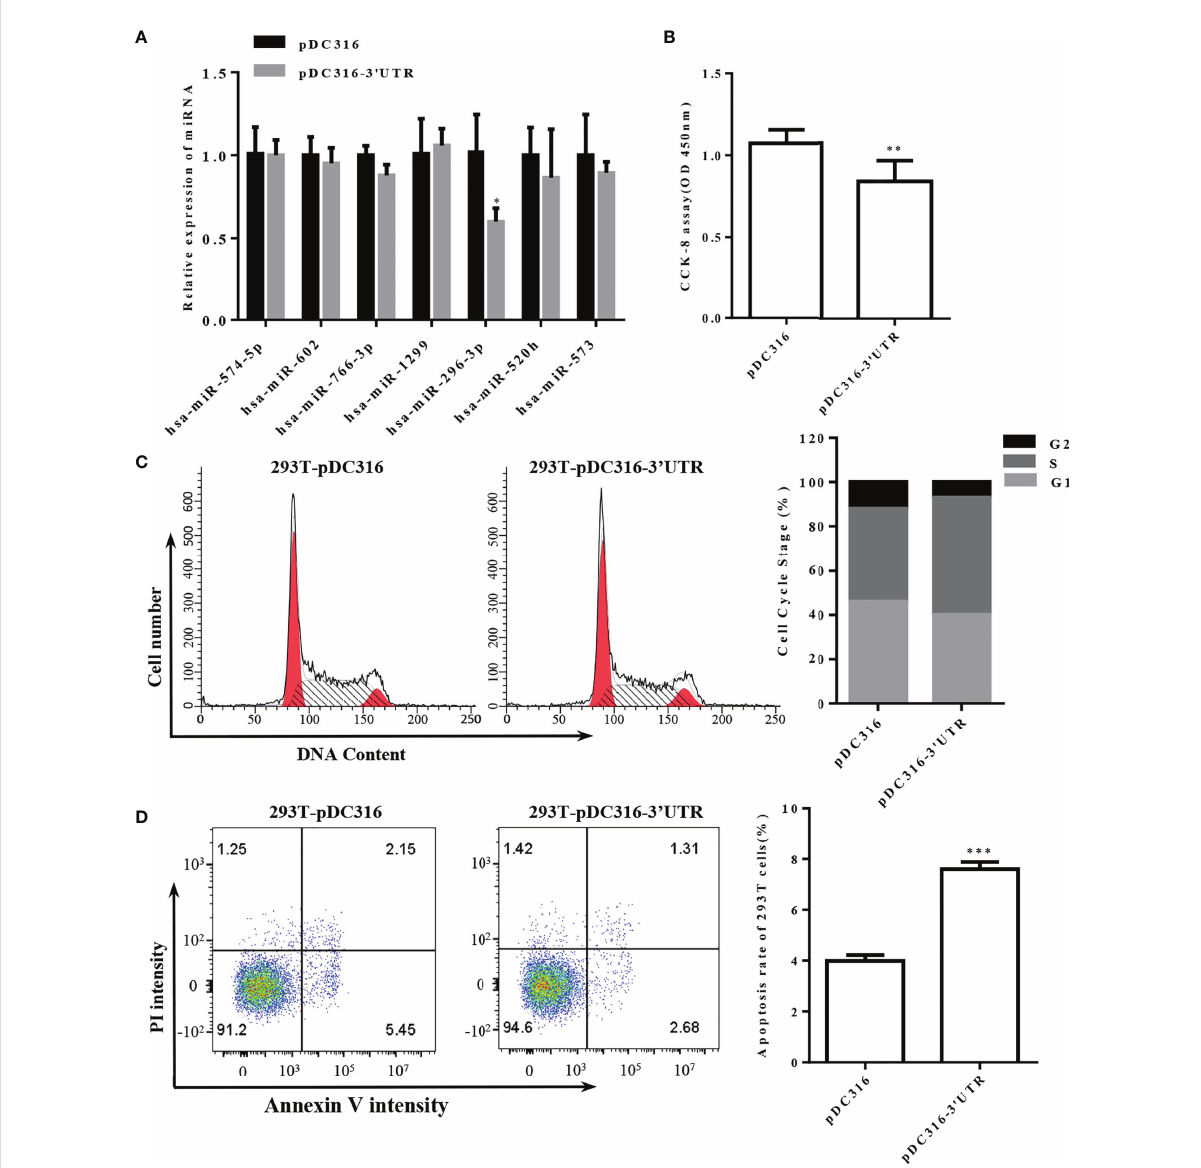
FIGURE 3 Overexpression of S-3 ′ UTR downregulated miR-296 expression and disturbed 293T cell growth. (A) Expression levels of miRNAs following overexpression of S-3 ′ UTR in 293T cells. Note that only expression of miR-296 was reduced. (B) 293T cell proliferation was detected by CCK-8. Note that overexpression of S-3 ′ UTR decreased cell proliferation. (C) Distribution of 293T cell cycle. Note that overexpression of S-3 ′ UTR increased the proportion of cells in S phase. (D) Apoptotic rate was detected by fl ow cytometry in 293T cells. Overexpression of S-3 ′ UTR increased apoptosis of 293T cells. (*p<0.05, **p<0.01,***p <